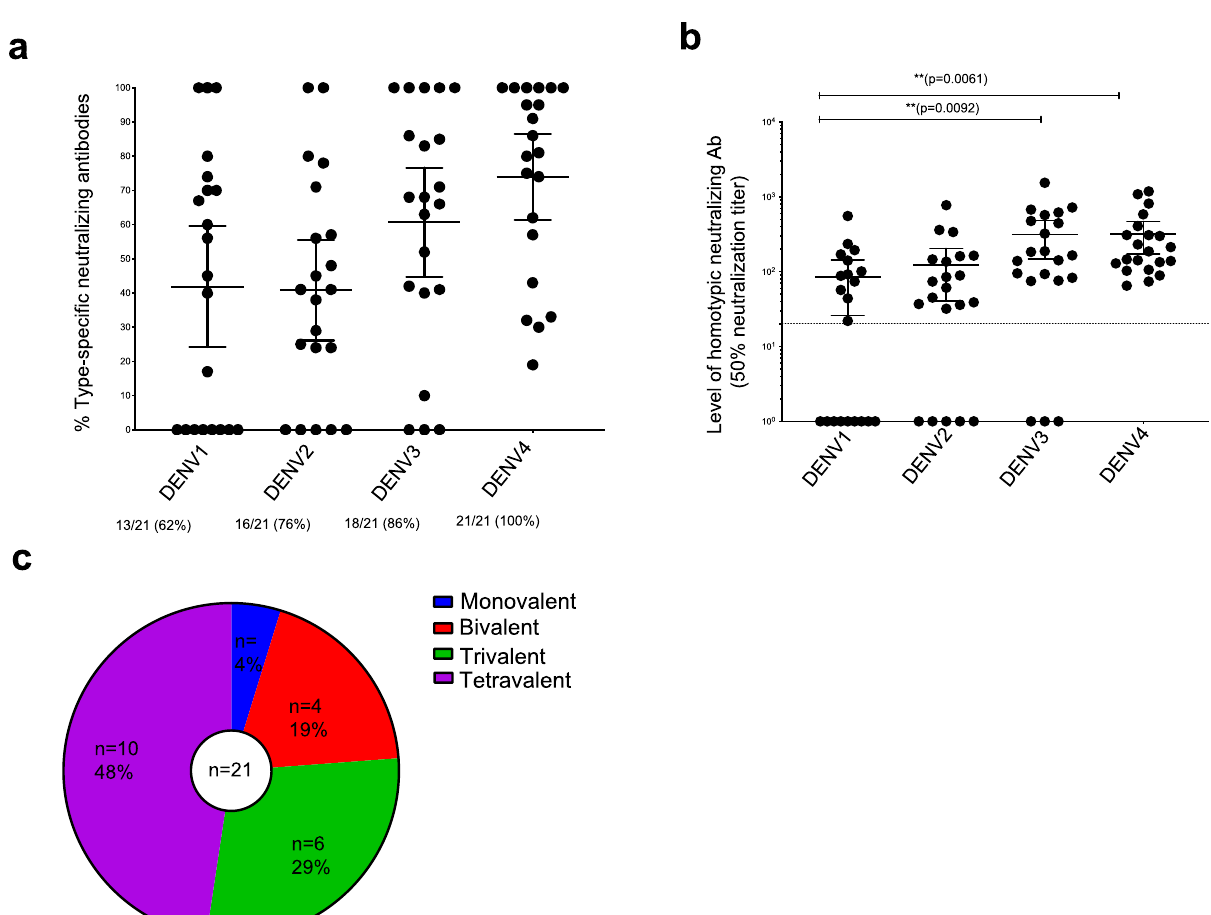
Fig. 2 Proportion and level of homotypic-neutralizing antibodies to each serotype in DENV naive subjects who received TV003. The antibody depletion assay was used to measure proportions of DENV TS (homotypic)-neutralizing antibodies induced by TV003 in ( n = 21) DENV naive subjects. a The percentage of the total-neutralizing antibody response to each serotype contributed by the serotype-speci fi c antibodies for each subject. b The absolute level of homotypic-neutralizing antibody to each serotype for each subject. c Number and % of subjects that developed an absolute TS nab titer >20 is depicted. Data were analyzed from a total number of 21 subjects indicated as dots from a single independent experiment and expressed as mean titers ±95% con fi dence intervals ( a , b ). Nonparametric one-way Anova with Friedman Dunn ’ s multiple comparisons test was used for determining the statistical differences between the level of TS nAbs across serotypes ( b ). Each p -value was adjusted to account for multiple comparisons. (**** p < 0.0001; *** p < 0.001 ; ** p < 0.01 ; * p < 0.05). The serotypes with signi fi cantly high levels of TS nabs compared to other serotypes is shown ( b ) (DENV3: ** p =